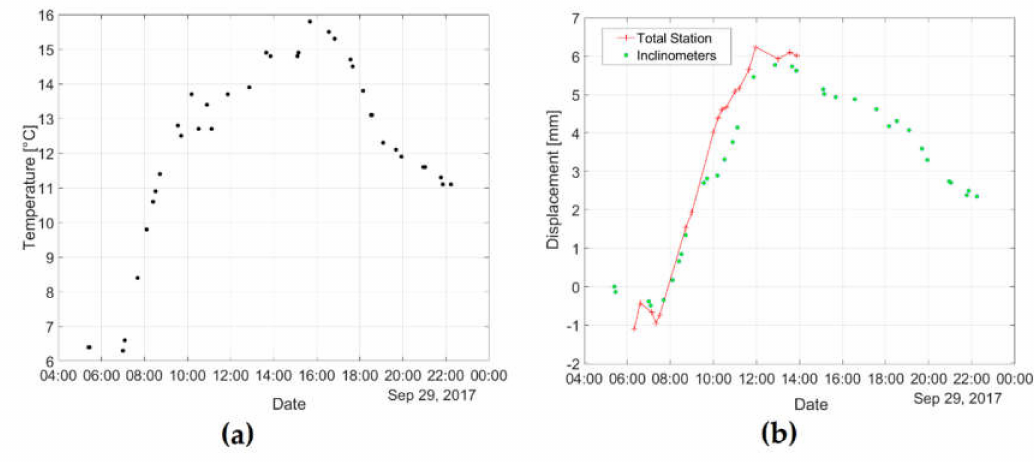
span length point: ( a ) Average 4